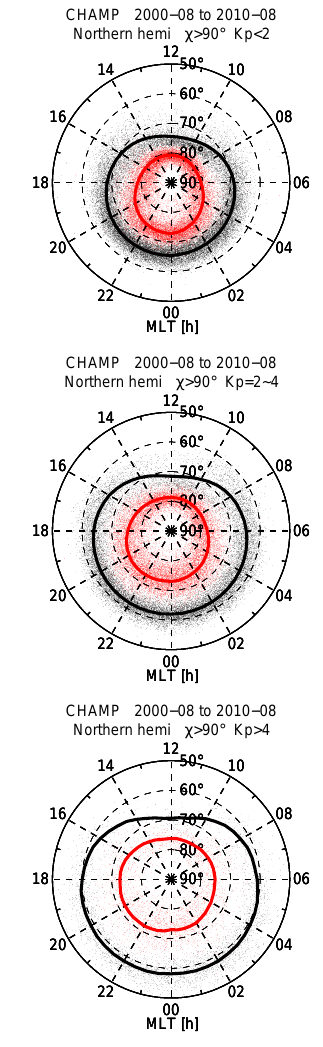
Figure 4. Distribution of equatorward (black) and poleward (red) boundary detections; solid lines are the mean latitudes of 0.5h bins. Fig. 4. Distribution of equatorward (black) and poleward (red) boundary detections, solid lines are the mean Events have been grouped into three magnetic activity classes con- latitudes of 0.5-hour bins. Events have been grouped into three magnetic activity classes controlled by the Kp trolled by the Kp index: quiet (top), moderate (middle), and dis- index, quiet (top), moderate (middle) and disturbed (bottom). Only Northern hemispheric results are presented. 22 turbed (bottom). Only northern hemispheric results are